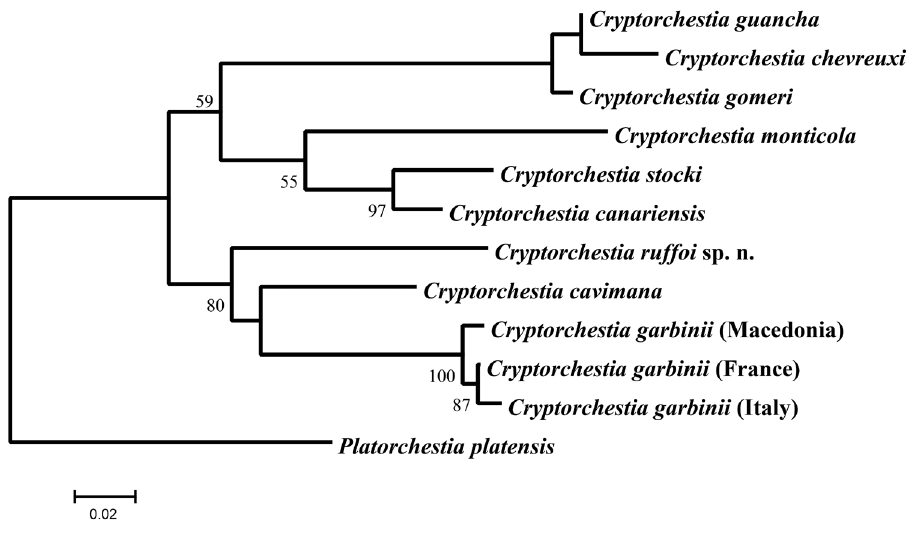
Figure 10. Molecular phylogeny by Maximum Likelihood method obtained in a combined analysis us- ing mitochondrial cytochrome oxidase I (COI) gene region (363 bp), and H3 histone (H3) gene fragment (330 bp) sequences (a total of 693 positions in the final dataset) from Cryptorchestia ruffoi sp. n. and other Cryptorchestia species reported in Table 1. Platorchestia platensis was used in this study as outgroup species. The tree is drawn to scale, with branch lengths measured in the number of substitutions per site. Nodes that have bootstrap values greater than 0.5 are labelled. The GenBank accession numbers of the newly determined sequences from the COI and the histone H3 genes used in this study are reported in Table